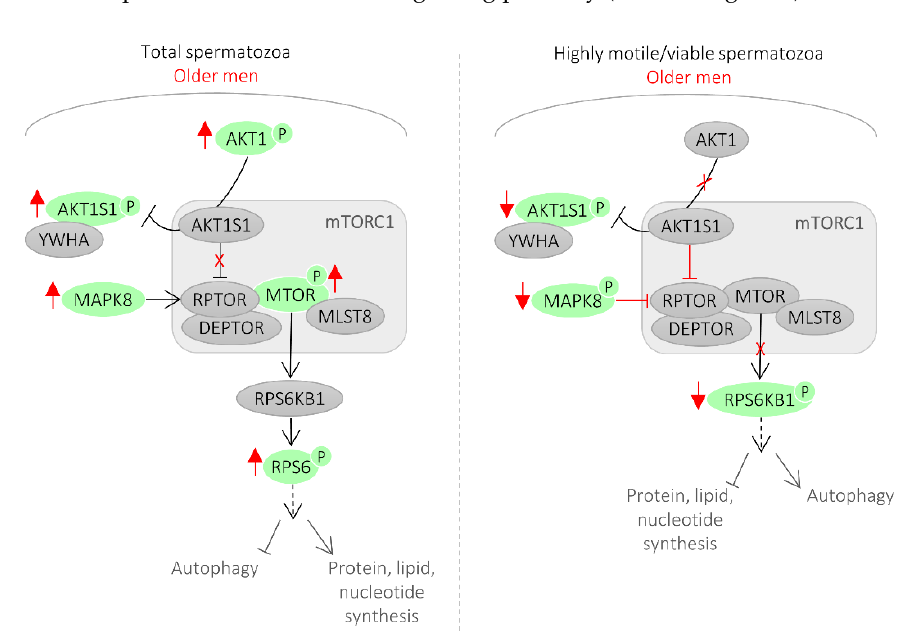
Figure 3. mTOR signaling in spermatozoa from older men. In older men, we observed an